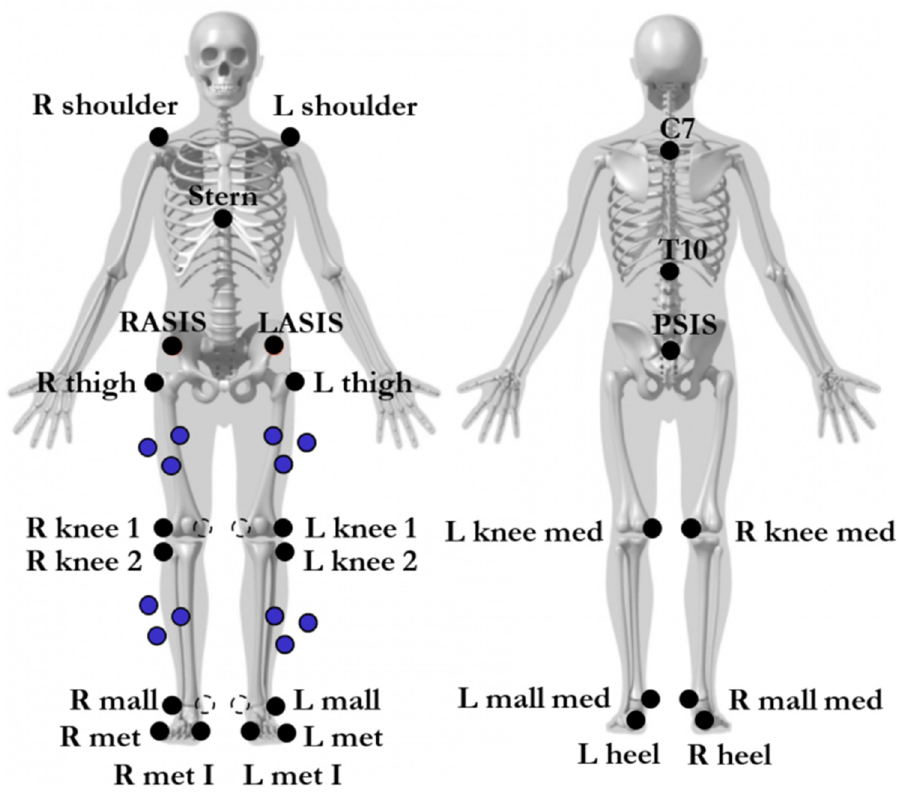
Figure 1. Cluster-based marker protocol with a 38 marker set. R shoulder, on the right acromion; L shoulder, on the left acromion; Stern, xiphoid process of the sternum; RASIS, on the right anterior superior iliac spine; LASIS, on the left anterior superior iliac spine; R thigh, on the center of the right great trochanter; L thigh, on the center of the left greater trochanter; R knee 1, on the lateral condyle of the right femur; L knee 1, on the lateral condyle of the left femur; R knee med, on the medial condyle of the right femur; L knee med, on the medial condyle of the left femur; R knee 2, on the lateral epicondyle of the right tibia; L knee 2, on the lateral epicondyle of the left tibia; R mall, on the center of the right lateral malleolus; L mall, on the center of the left lateral malleolus; R mall med, on the center of the right medial malleolus; L mall med, on the center of the left medial malleolus; R met, on the fifth metatarsal of the right foot; L met, on the fifth metatarsal of the left foot; R met I, on the first metatarsal of the right foot; L met I, on the first metatarsal of the left foot; R heel, on the right heel; L heel, on the left heel; C7, on the spinous process of the seventh cervical vertebra; T10, on the tenth thoracic vertebra; PSIS, on the mid-point of the right and left posterior superior iliac spine.